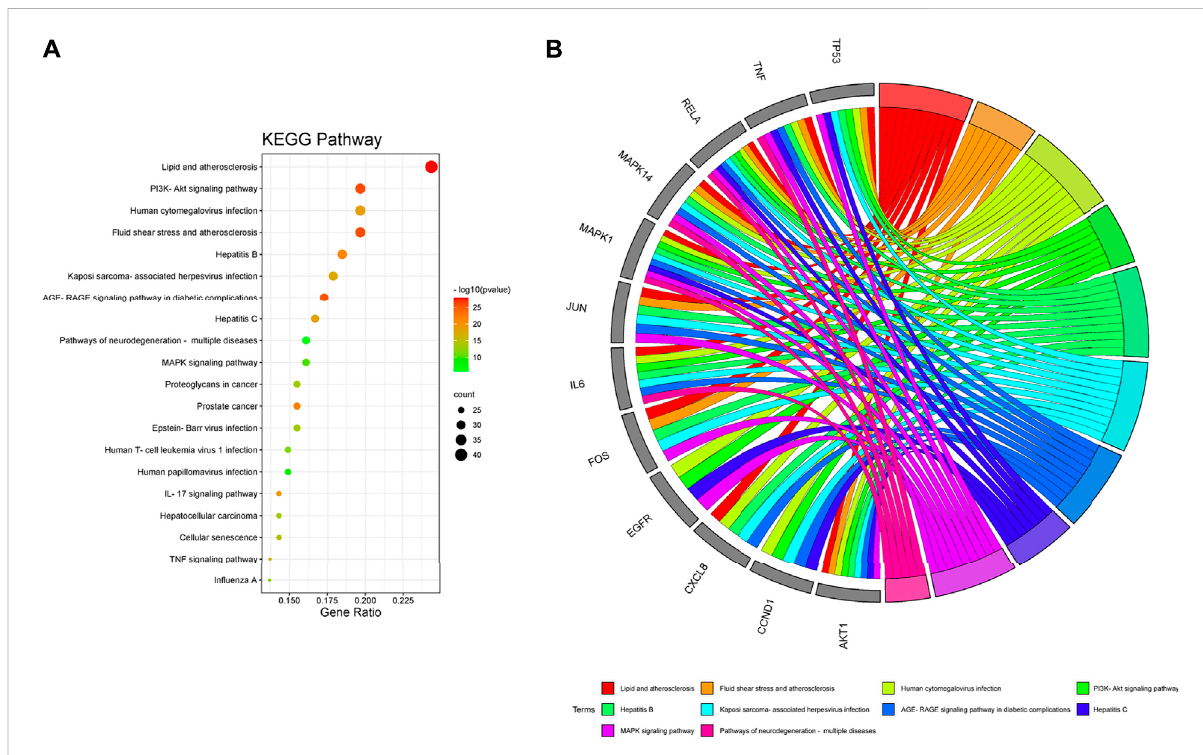
FIGURE 7 KyotoEncyclopediaofGenesandGenomes(KEGG)pathwayenrichmentanalysisofPDinthetreatmentofcoloncancer. (A)